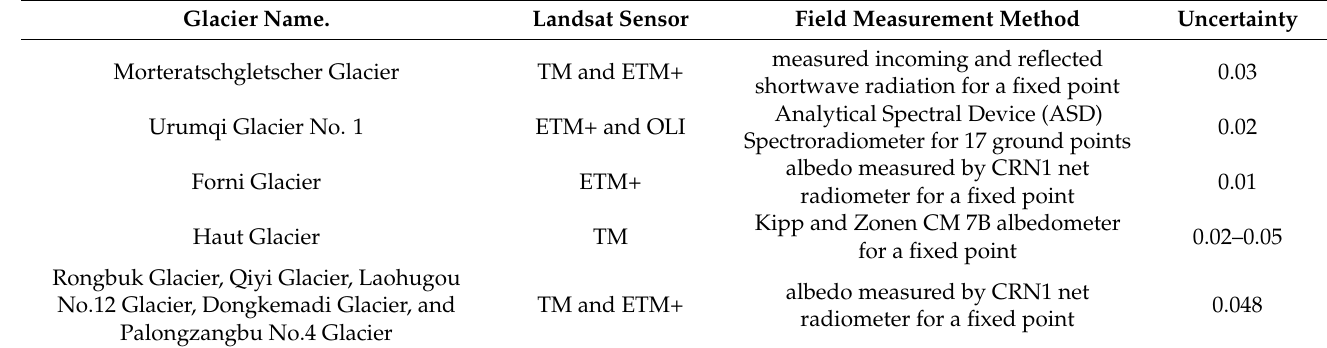
Table 3. The overview of uncertainties in the Landsat-retrieved albedo values at different glaciers. Glacier Name. Landsat Sensor Field Measurement Method Uncertainty measured incoming and reflected Morteratschgletscher Glacier TM and ETM+ 0.03 shortwave radiation for a fixed point Analytical Spectral Device (ASD) 0.02 Urumqi Glacier No. 1 ETM+ and OLI Spectroradiometer for 17 ground points albedo measured by CRN1 net Forni Glacier ETM+ 0.01 radiometer for a fixed point Kipp and Zonen CM 7B albedometer Haut Glacier TM 0.02–0.05 for a fixed point albedo measured by CRN1 net TM and ETM+ radiometer for a fixed point Palongzangbu No.4 Glacier